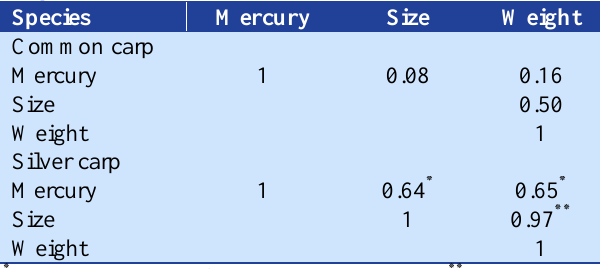
Table 3. Correlation of size, weight, and metals levels in the muscle of common carp and silver carp